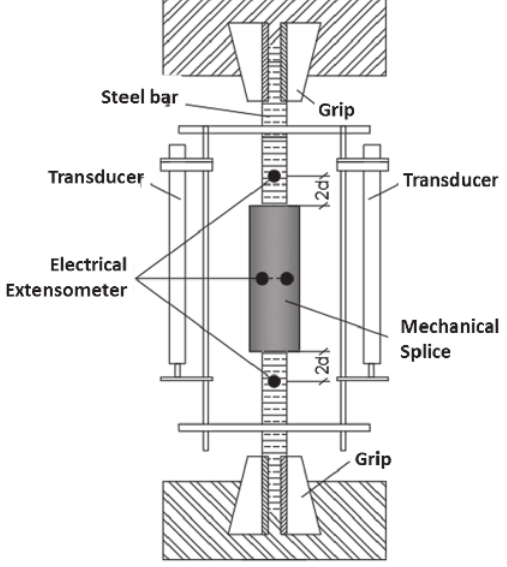
Instrumentation scheme of transducers installed in groups of three used in test method 3